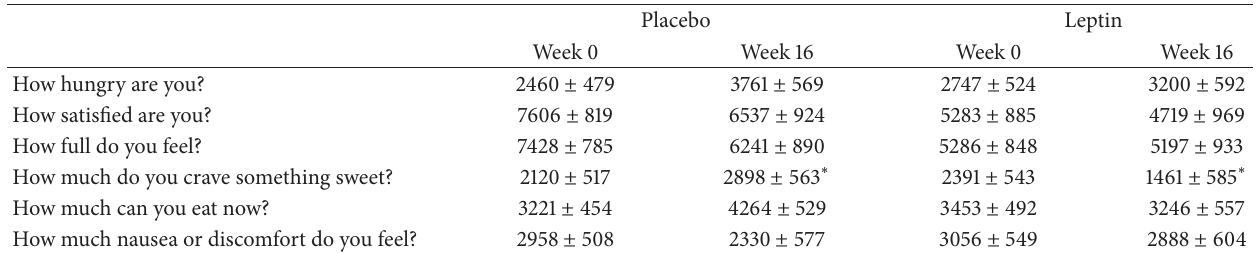
Table 3: Visual analog